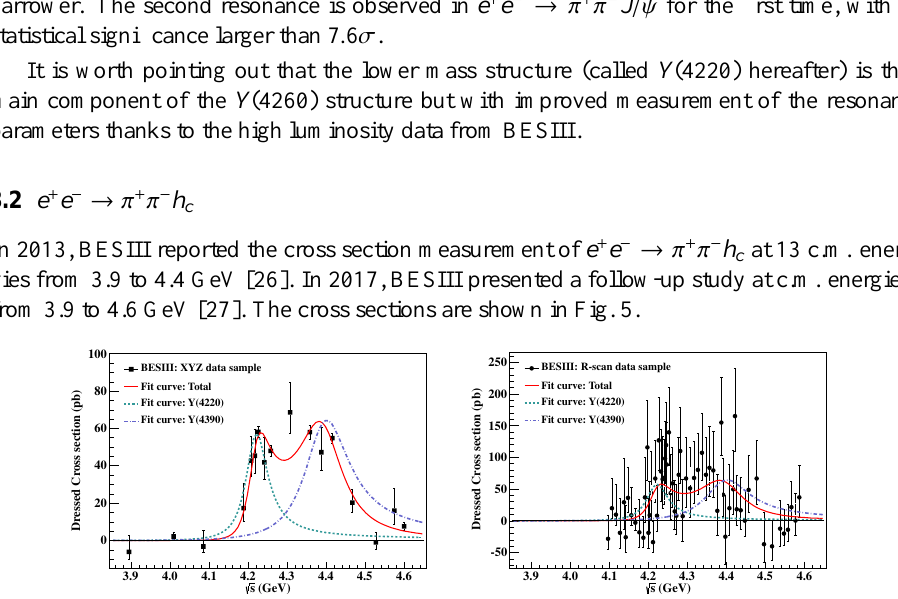
Figure 5. Fit to the cross section of e + e − → π + π − h c with the coherent sum of two BW functions (solid